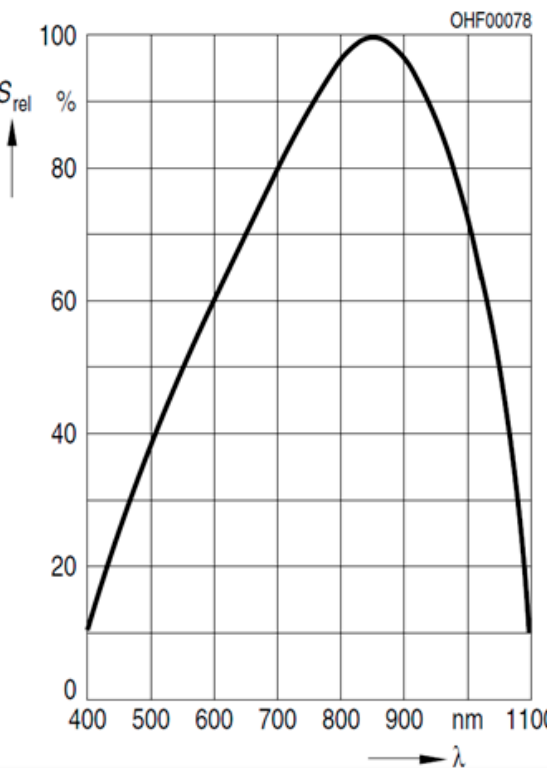
Figure 9. Relative Spectral Sensitivity function of the sensor Ŝ λ [21].